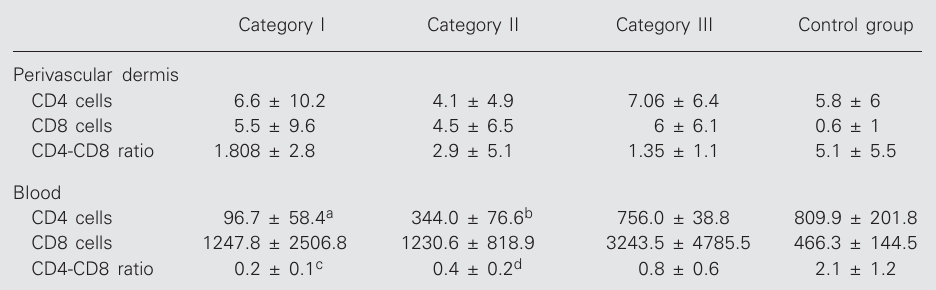
Table 2. Numbers of CD4 and CD8 T cells in the perivascular dermis and